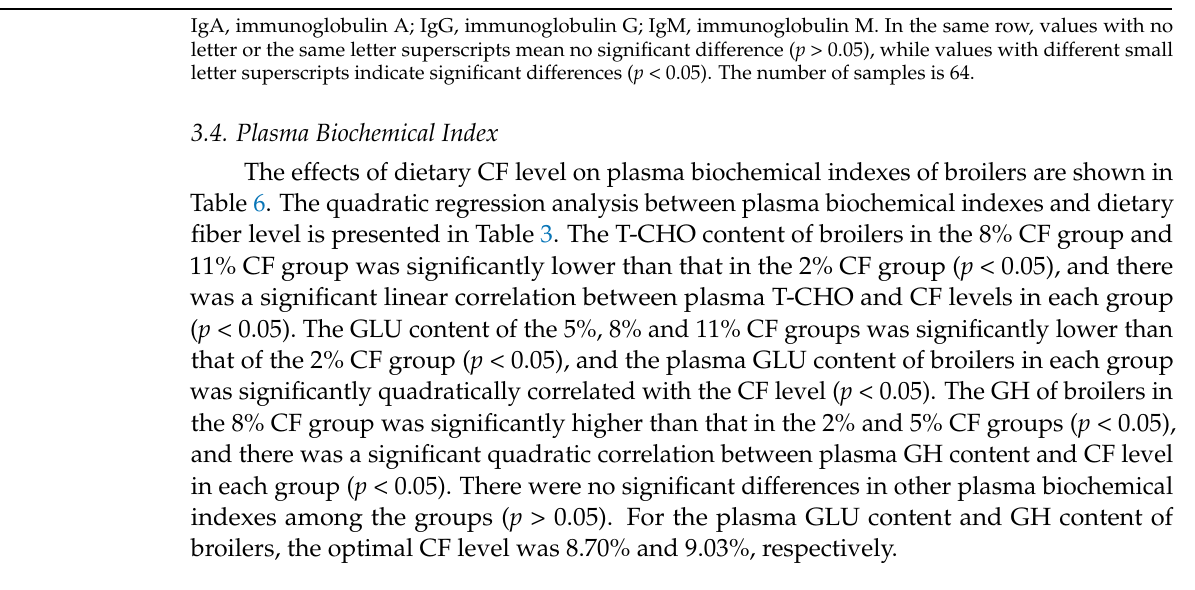
Table 6. Effects of dietary CF level on plasma biochemical indexes of broilers on day